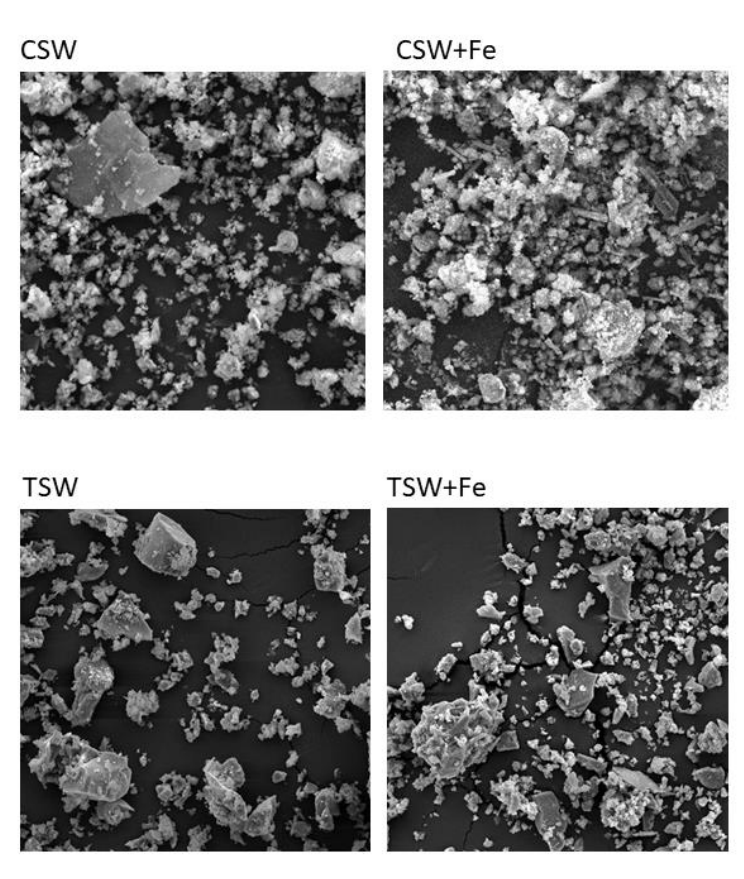
Figure 3. SEM images of CSW and TSW before ( left ) and after ( right ) surface modification (magnifi- cation of 700 ×